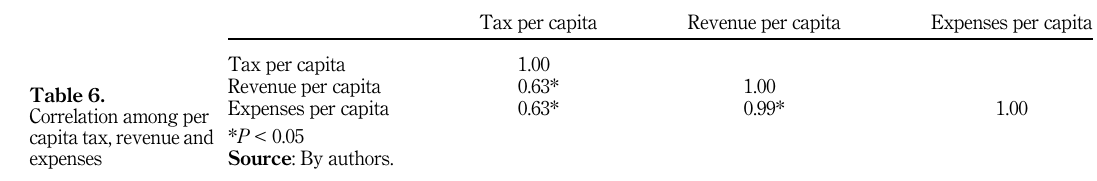
capita tax, revenue and